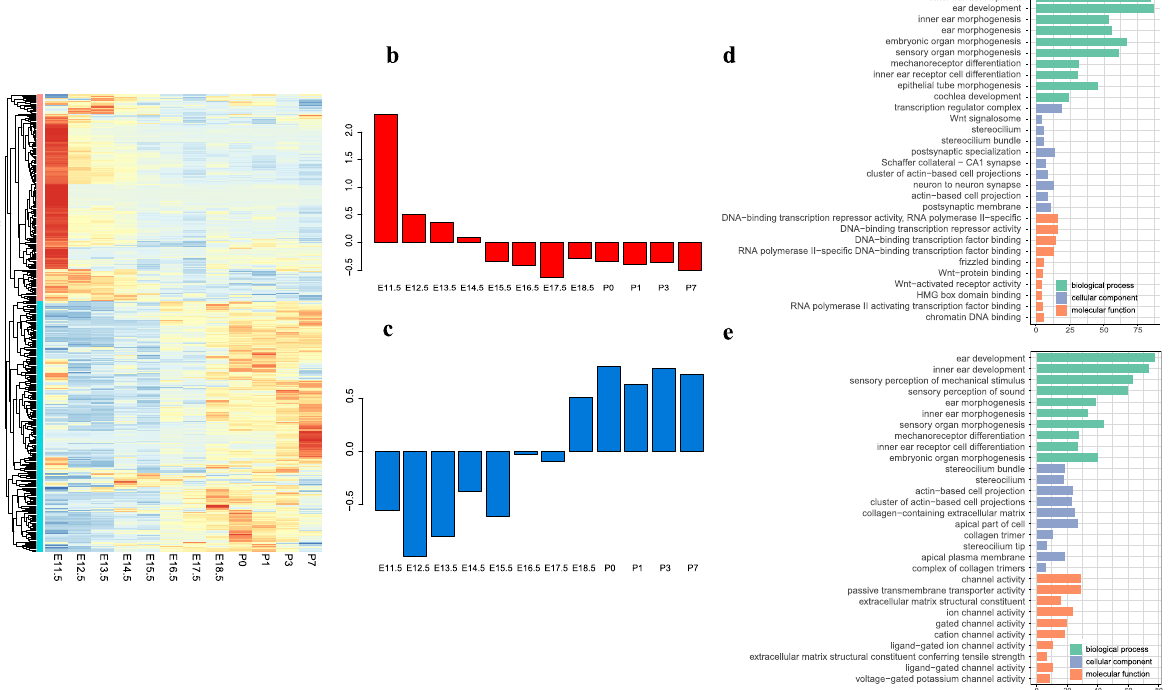
Figure 3. Expression of hearing related genes and the pathways or biological processes they are involved. ( a ) Expression of hearing related genes; ( b ) Downregulated cluster of genes and their average temporal expression levels; ( c ) Upregulated cluster of genes and their relative expression value; ( d ) Top 10 enrichment GO terms for downregulated clusters; ( e ) Top 10 enrichment GO terms for upregulated genes. Details of the enrichment result for hearing related genes can be found in Supplementary Data